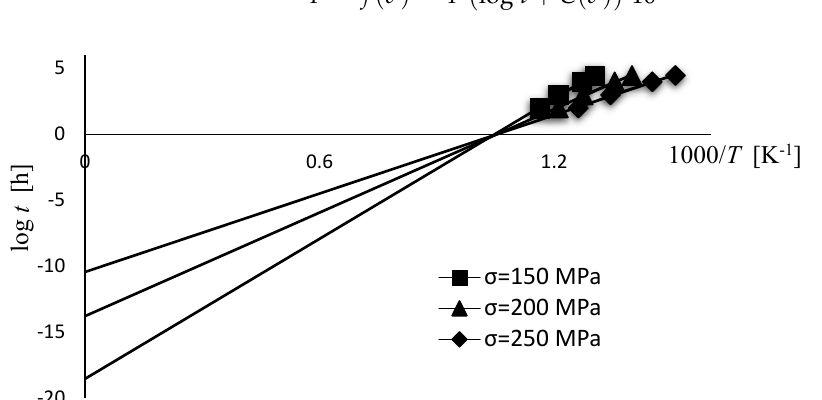
Figure 1. Example of iso − stress lines for 10CrMo9–10 steel [20] presented in a plot of (log t ) vs. (1/ T ).